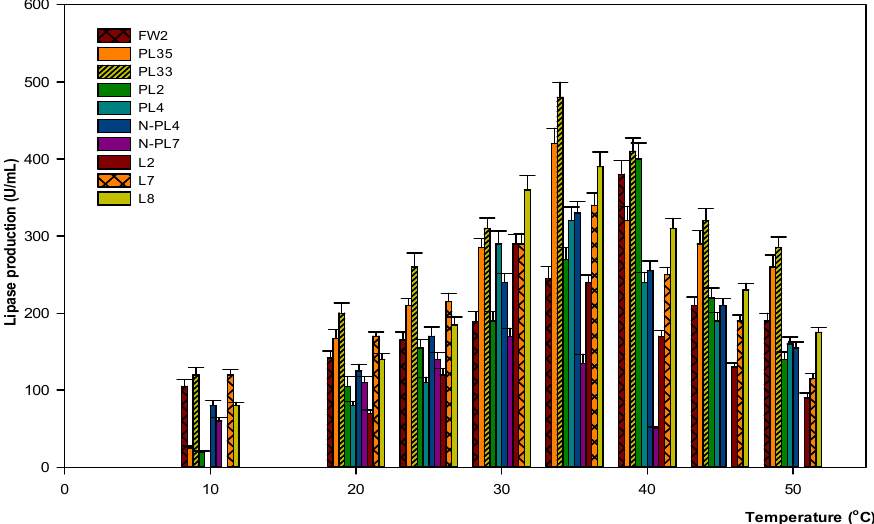
Figure 2. The effect of different temperatures on lipase production. Ten bacterial cultures were adjusted to a pH of 7 and incubated for 72 h. Experiments were performed in triplicate.